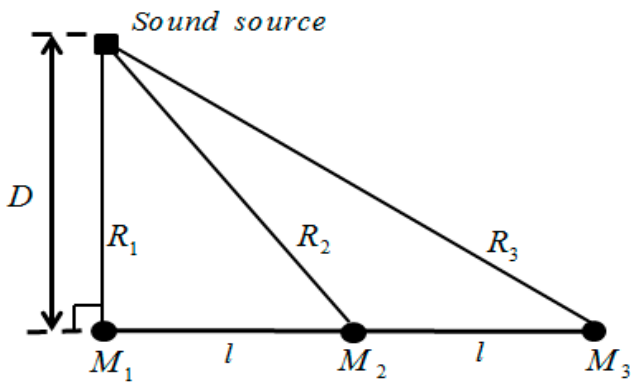
Figure 1. Geometric structure of the microphones and sound source in two-dimensional (2D) space.